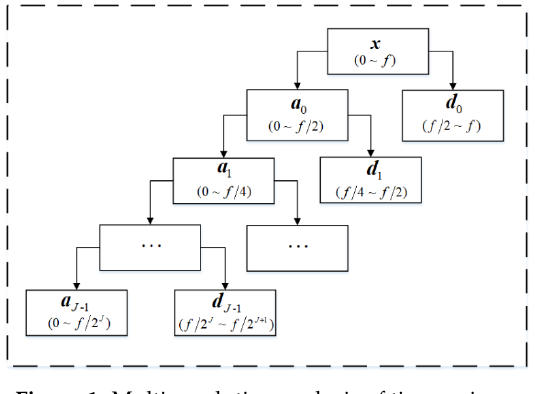
Figure 1. Multi-resolution analysis of time series x .